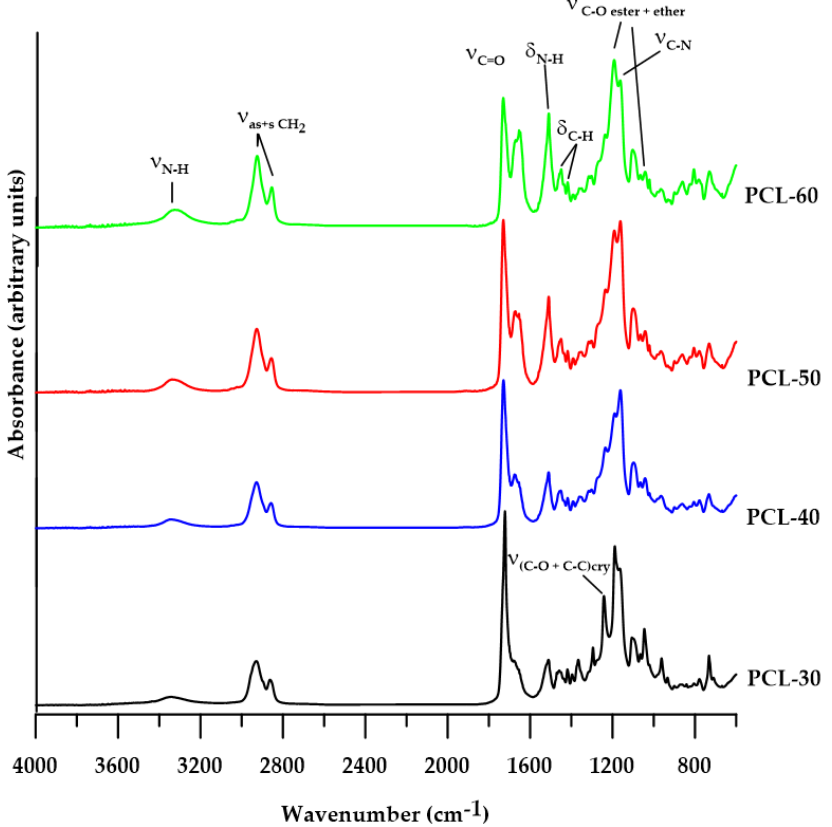
Figure 2. FTIR spectra of synthesized polymers.